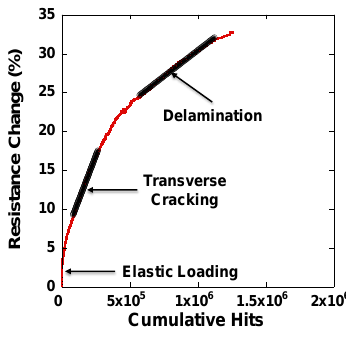
Figure 6. The electrical resistance change with cumulative acoustic hits showing the ability to identify